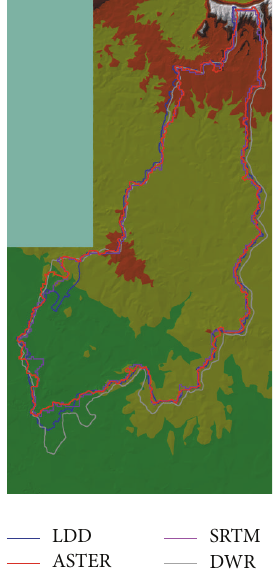
Figure 4: Watershed delineation for Huai-Sai-Bath